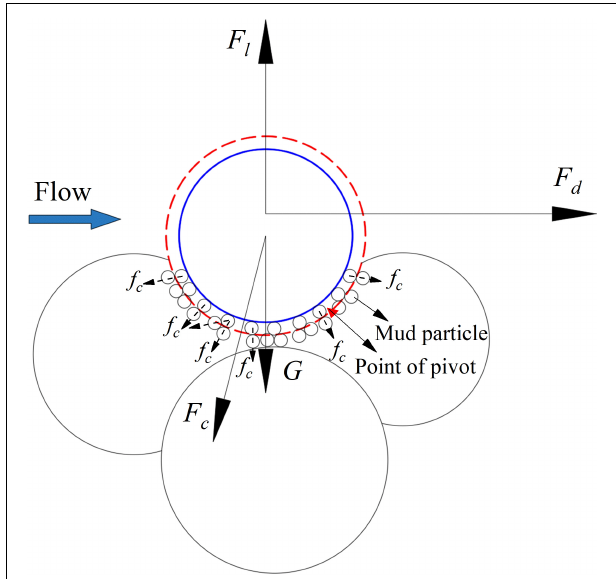
FIGURE 3 | Forces acting on a sand particle (or a mud parcel) in the surface of a sand-dominated mixture (a mud-dominated mixture). For the sand-dominated mixture, regard the blue circle as a sand particle and the red circle as the coating layer; for the mud-dominated mixture, regard the red circle as a mud